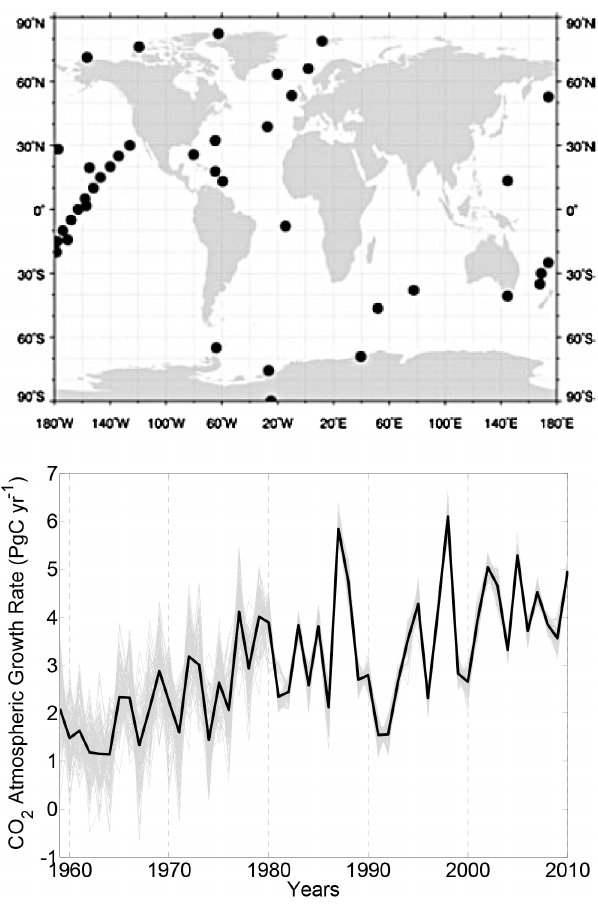
Figure 2. The global observation network used in calculating the annual atmospheric CO 2 growth rate. The annual growth rate of at- mospheric CO 2 is calculated from resampling sites in the global network located in the marine boundary layer (black points; top panel). The annual growth rate since 1980 is calculated from the entire marine boundary layer, while the growth rate prior to 1980 is calculated from observation sites at Mauna Loa, Hawaii, USA, and the South Pole, Antarctica. The mean atmospheric growth rate is illustrated as a thick black line and growth rates calculated from the 100 simulated sampling networks are illustrated by the thin grey